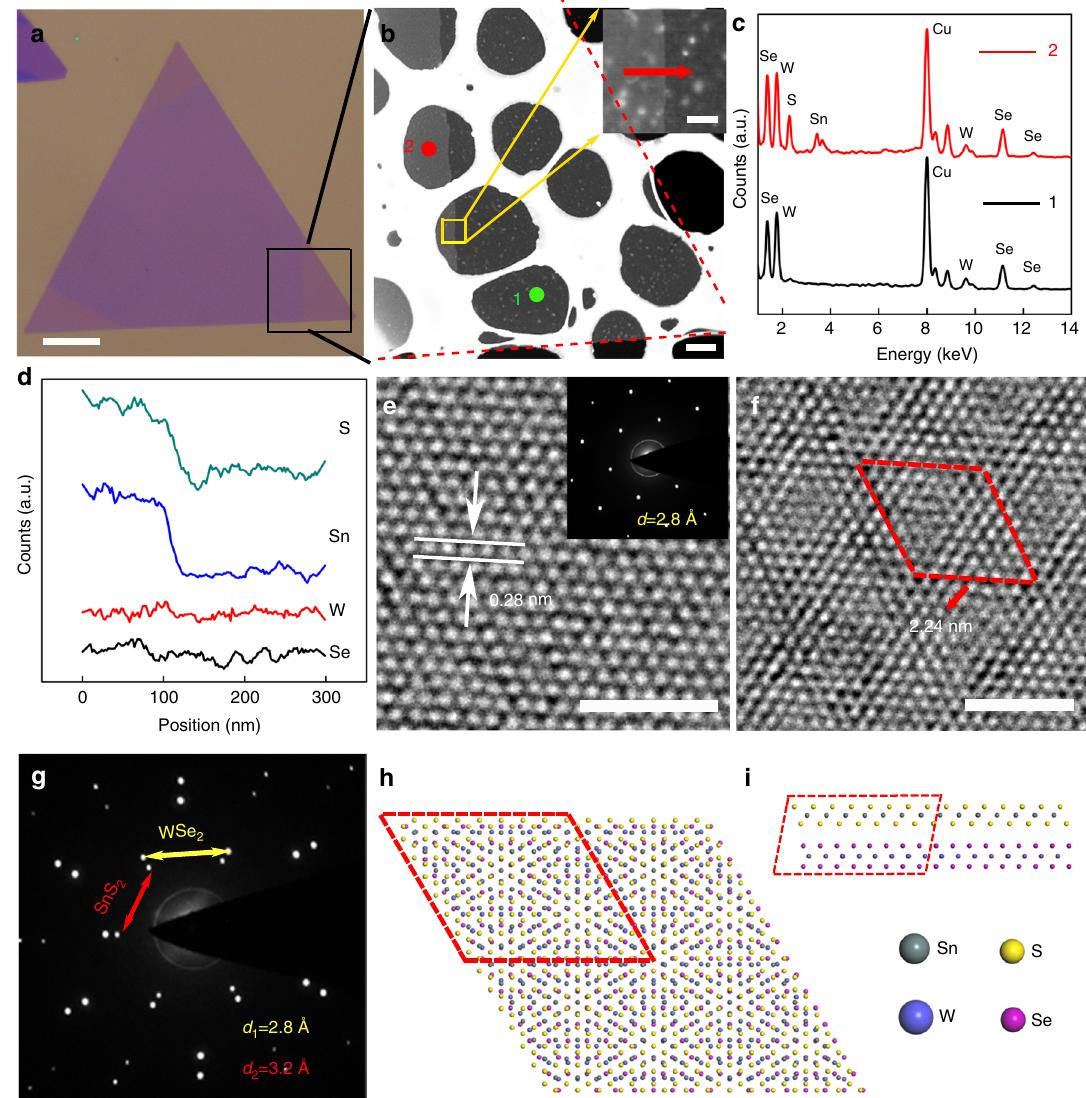
Fig. 2 Atomic structure of the vertically stacked WSe 2 /SnS 2 heterostructure. a A typical optical image of the heterostructure with three interfaces at the corners of the triangle fl ake. Scale bar, 30 μ m. b Low-resolution TEM image of the interface from the black rectangle region in a . Scale bar, 5 μ m. Inset is the enlarged interface image highlighted in the yellow rectangle. Scale bar, 100 nm. c EDS results of point 1 and point 2 in b , marked by green and red colors, respectively. d Line scans of S, Sn, W, Se elements distribution across the red arrow in the inset of b . e HRTEM image taken on the green point 1 region in b . Scale bar, 2 nm. Inset is the SAED pattern of the bare WSe 2 . f HRTEM image taken on the red point 2 region in b , indicating the vertical stacked WSe 2 /SnS 2 vdW heterostructure with Moiré pattern. Scale bar, 2 nm. g The SAED pattern collected from point 2 region shows two sets of electron diffraction patterns, corresponding to WSe 2 and SnS 2 , respectively. h , i Top view and side view of the atomic model of the WSe 2 /SnS 2 vdW heterostructure, respectively. The supercell is highlighted by red dashed